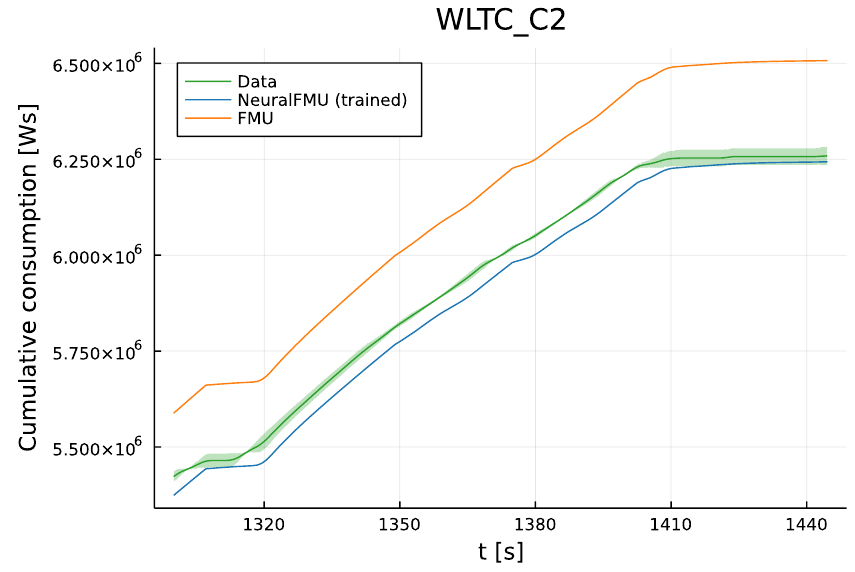
Figure 14. Deviation on the last 10% of the simulation trajectory of the NeuralFMU (blue) compared to the original FPM/FMU (orange) and experimental data mean (green). The unknown WLTC Class 2 is used for testing. The NeuralFMU prediction is much closer to the data mean than the original FPM and predicts a final value inside of the measurement